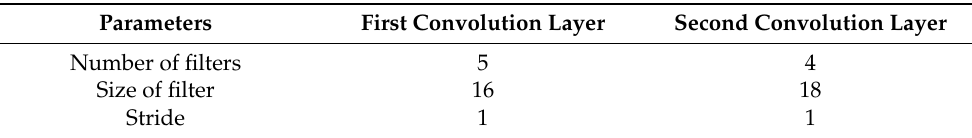
Table 5. Convolutional network settings.